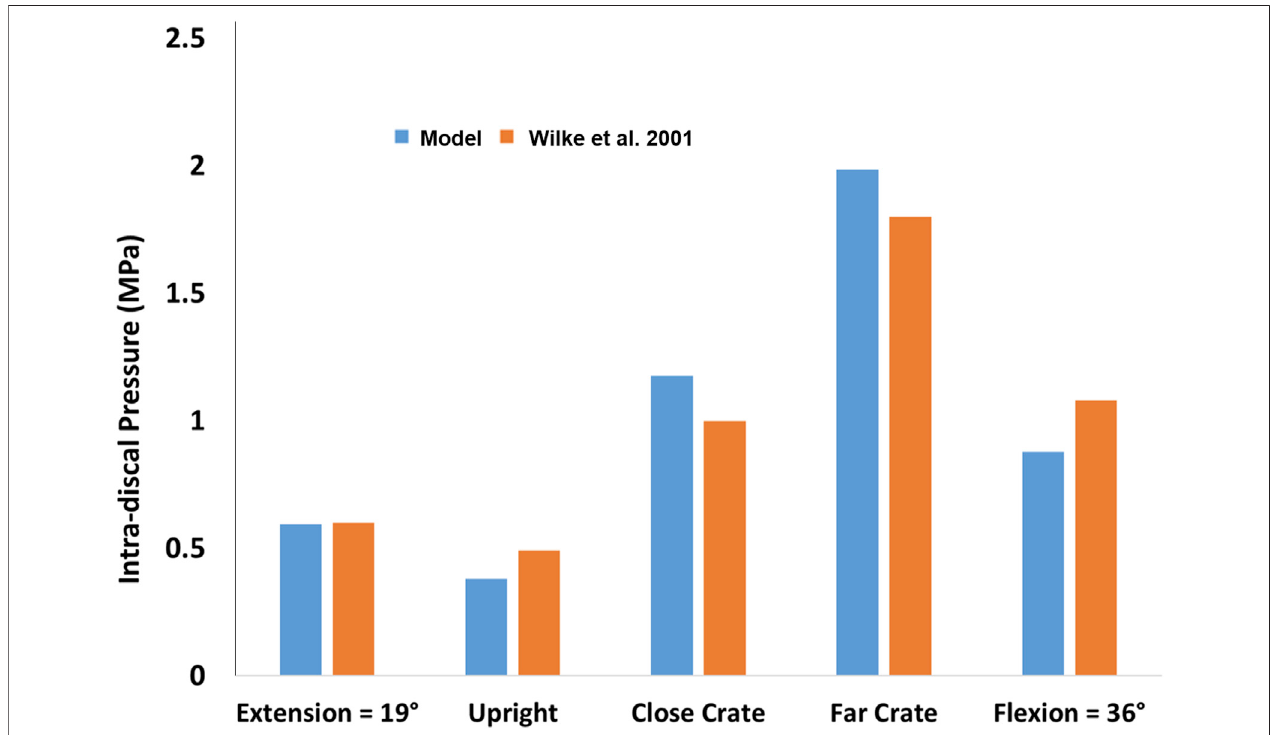
FIGURE 3 | Comparison between the predicted L4-L5 IDP by the model and those measured in vivo for fi ve different activities (Wilke et al., 2001).